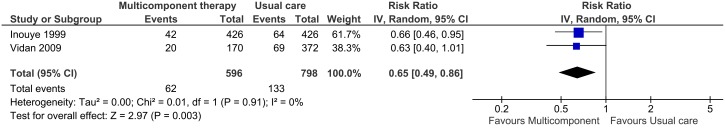
Forest plot of risk ratios comparing multicomponent non-pharmacological interventions vs usual care for delirium prevention in older patients in medical setting.